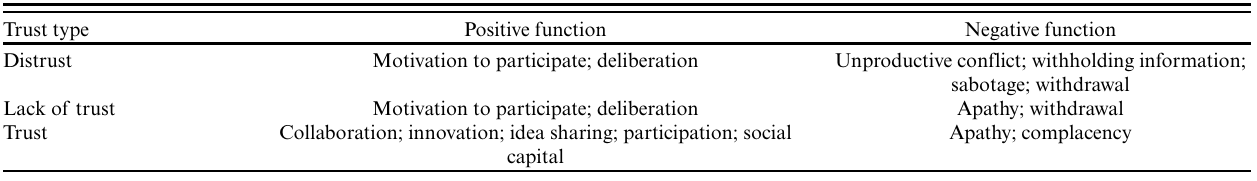
Table 2. Examples of positive functions (those contributing to effectiveness and resilience) and negative functions (those detracting from effectiveness and resilience) of distrust, lack of trust, and